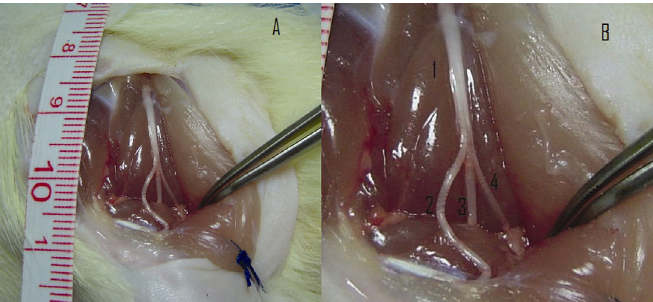
FIGURE 1 - Trans-operatory picture dissection: identification of the sci- atic nerve and its terminal branches. A) Aspect of LPL anatomical dissec- tion after the rupture of the superficial musculature. B) Identification of the sciatic nerve (1), fibular nerve (2), tibial nerve (3) sural nerve